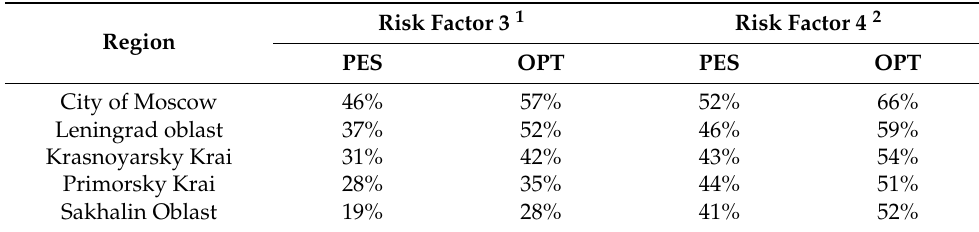
Table 3. Assessment of risk factors influence on achieving the goals for MSW sorting in selected regions of the Russian Federation (Part II).